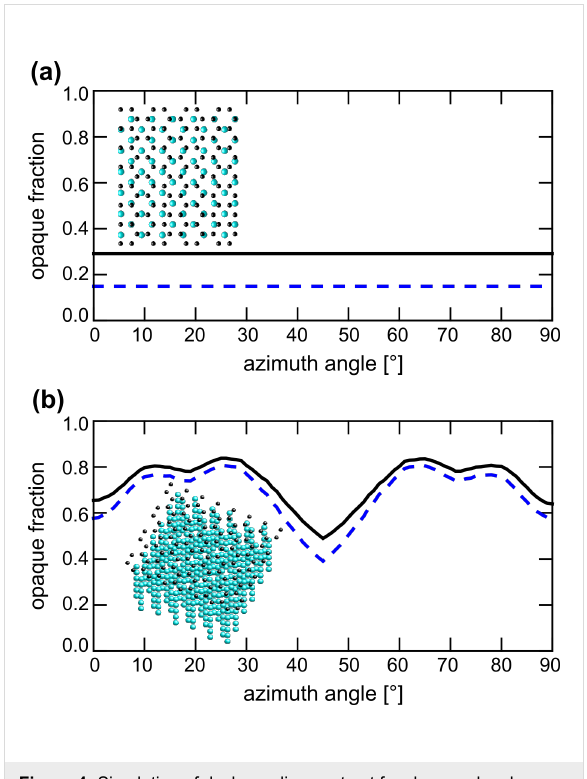
Figure 4: Simulation of dechanneling contrast for clean and carbon- covered Si. The graphs show the opaque fraction of the projected crystal lattice. Blue dashed lines are obtained for a clean Si(001) crystal, whereas the black lines are obtained with a thin carbon layer added. (a) Normal incidence. The opaque projected area fraction is 15 and 29% for the clean and carbon-covered surface, respectively. There is no azimuthal dependence for this incident angle. (b) The same calculation but for a 10° sample tilt. The average opaque projected area fractions are 68 and 73% for the clean and carbon covered surface, respectively. A clear dependence on the azimuthal angle